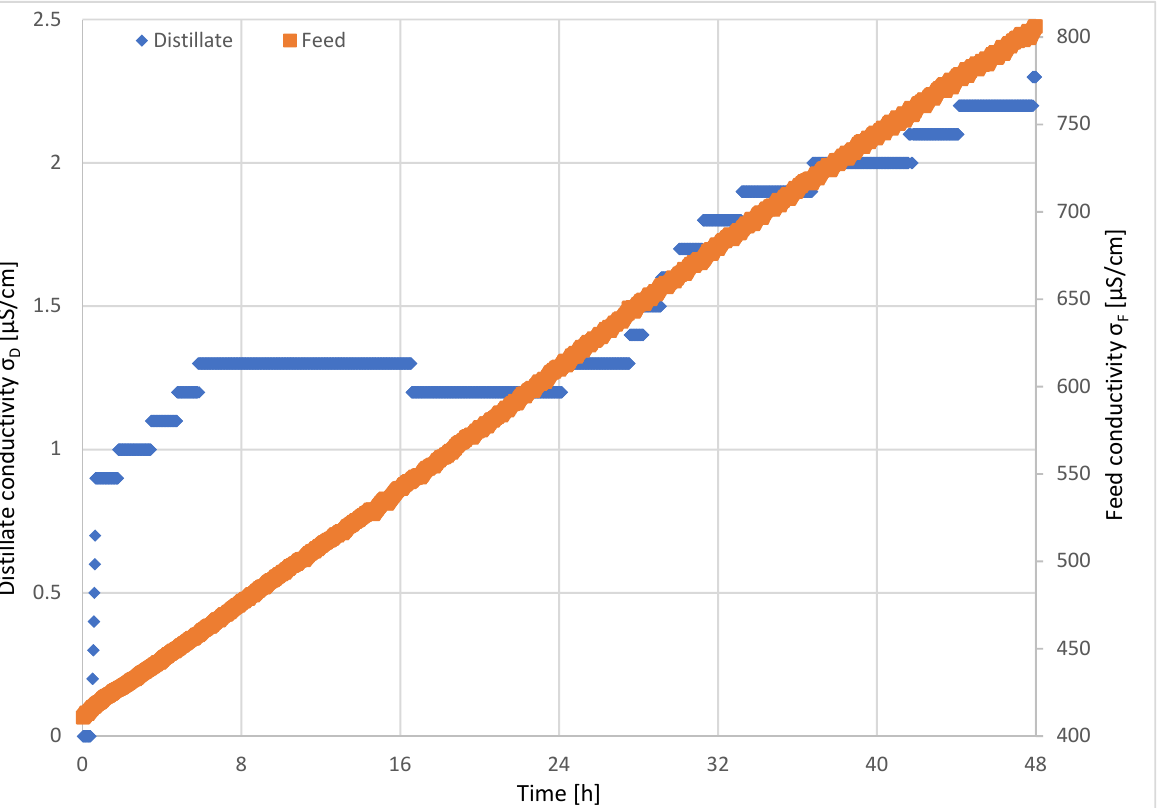
Figure 11. Feed and distillate conductivity during long-term investigations of AGMD. T F = 64.6 °C, F F = 60 L/h, F K = 130 L/h, T K , in = 16.9 °C.